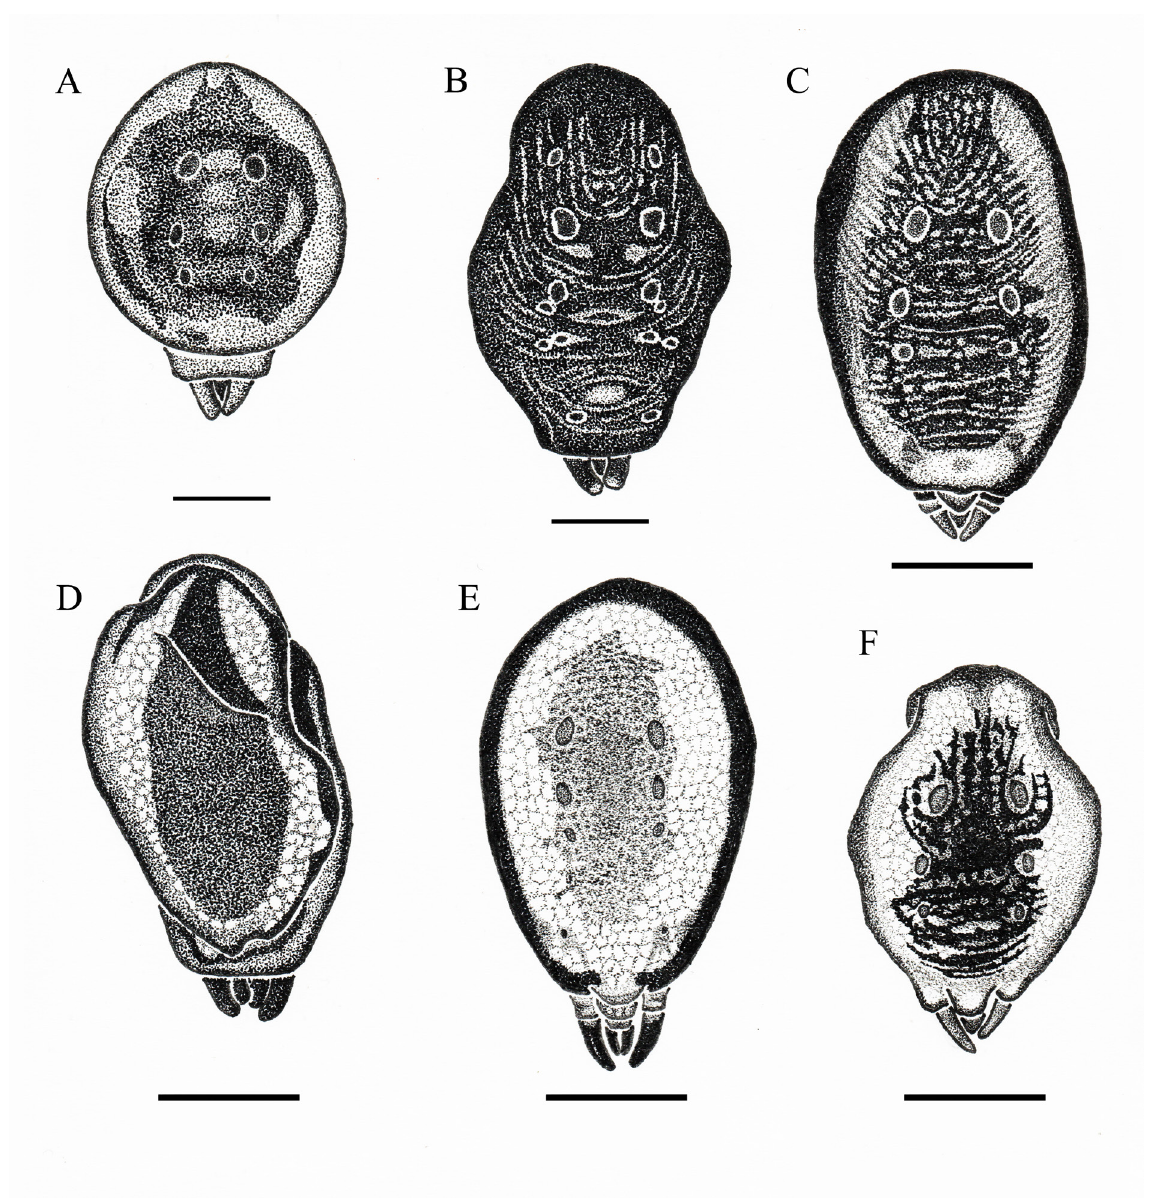
Fig. 6. Abdominal patterns, dorsal views. A – D . Uroctea grossa Roewer, 1960. A – B . ♀♀ from Iran, Damavand County, Havir village (MHNG). C . ♀ from Mazandaran Province, Larijan (MHNG). D . ♂ from Mazandaran Province, Larijan (MHNG). E . Uroctea gambronica sp. nov., holotype, ♂ (NMP-P6j-180/2002). F . Uroctea thaleri Rheims, Santos & van Harten, 2007, ♂ from Hormozgan Province, Minab County (MHNG). Scale bars = 2